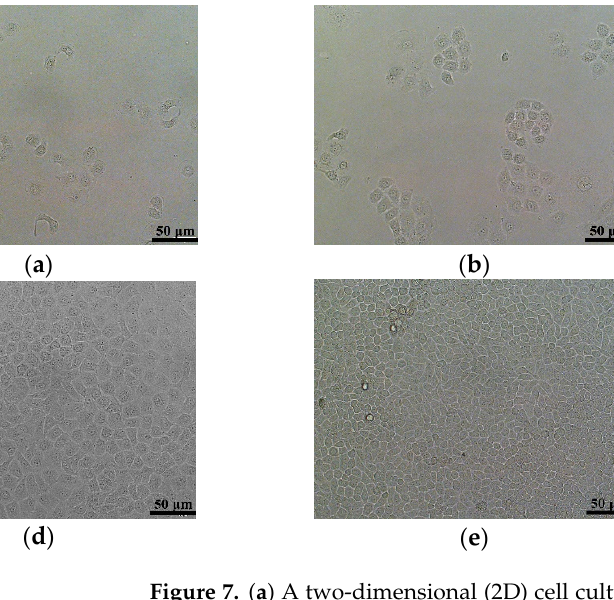
Figure 7. ( a ) A two-dimensional (2D) cell culture image on day 1. ( b ) A 2D cell culture image on day 3. ( c ) A 2D cell culture image on day 5. ( d ) A 2D cell culture image on day 7. ( e ) A 2D cell culture image on day 10. ( f ) A 2D cell culture image on day 13.